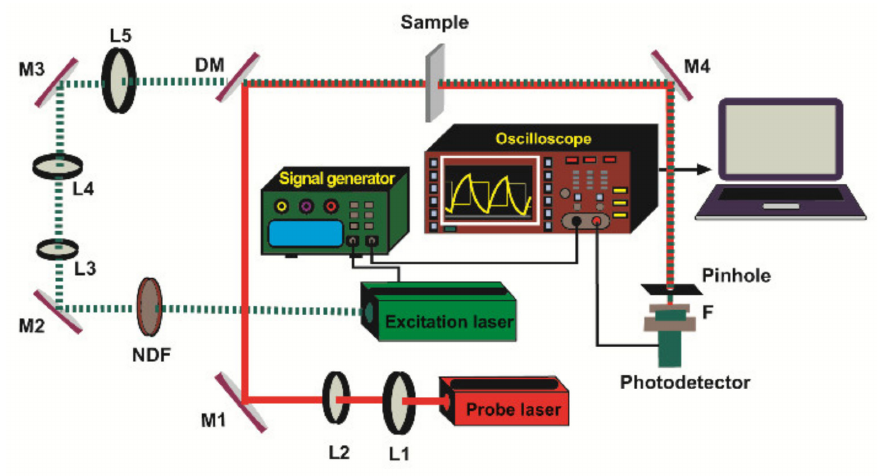
Figure 2. Scheme of the dual-beam mode-mismatched configuration. L1, L2, L3, L4, L5: lenses, M1, M2, M3, M4: turning mirrors, DM: dichroic mirror, NDF: neutral density filter, F: